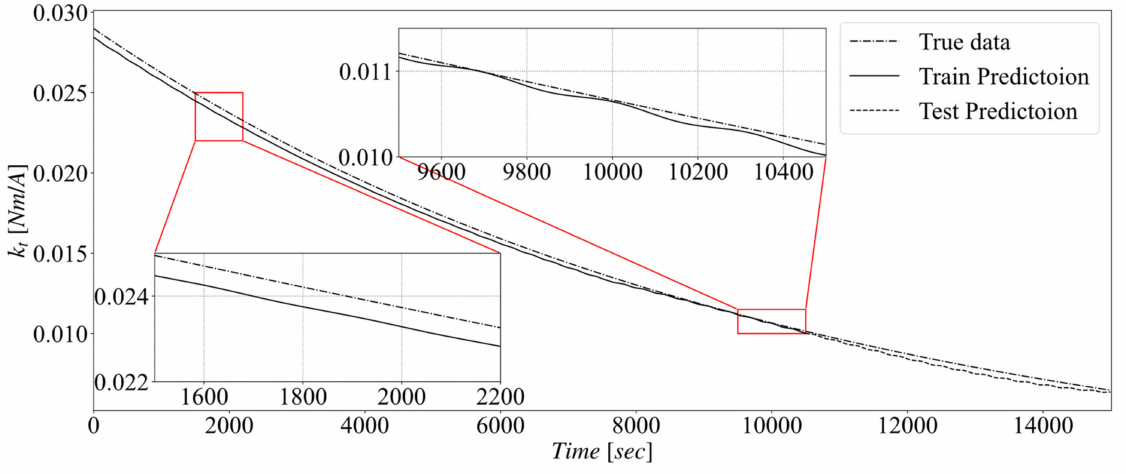
Figure 13. Prediction of HI parameter ( k t ).